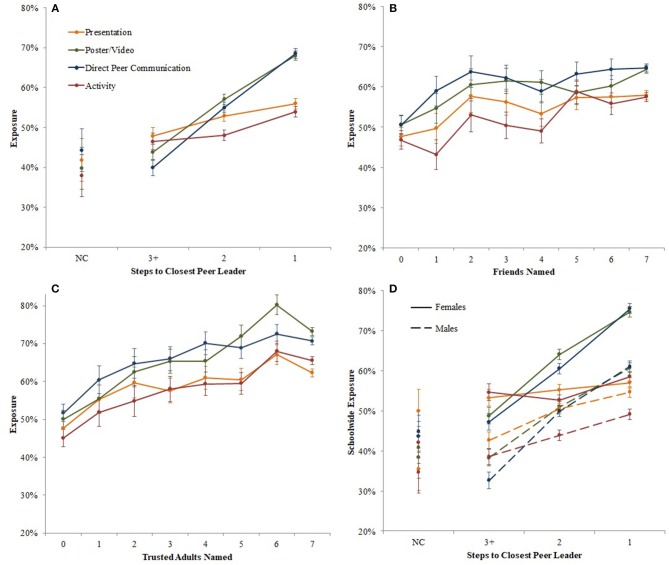
School-wide intervention exposure by (A) steps to closest peer leader, (B) number of friends named, (C) number of trusted adults named, and (D) steps to closest peer leader, stratified by gender (female = solid lines, male = dashed lines). Error bars represent one standard error.